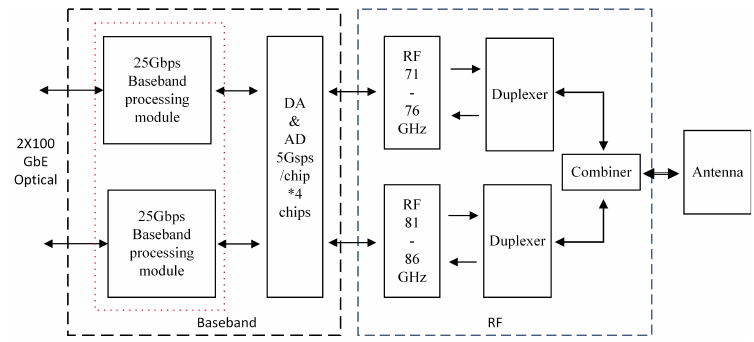
Figure 11. Block diagram of E-band wireless transceiver platform.